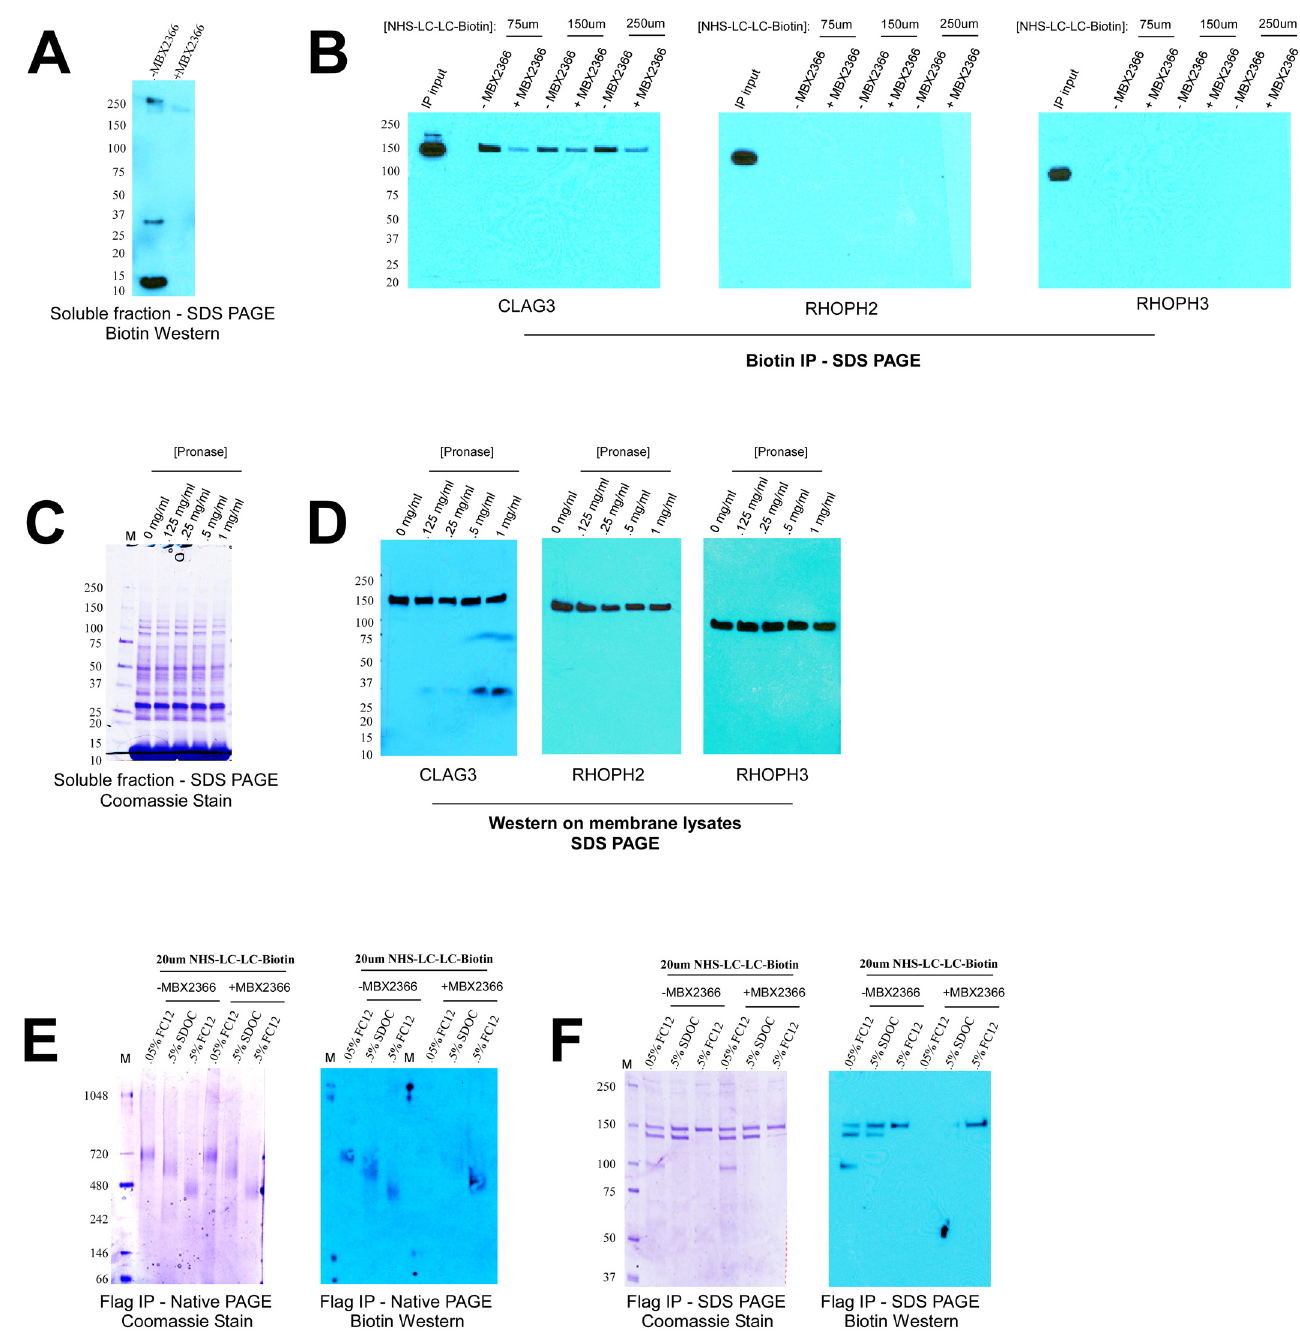
Fig 4. The 480kDa complex composed of CLAG3 localizes to the erythrocyte membrane. (A) Incubation of infected erythrocytes with extracellular NHS-LC-LC-Biotin results in labeling of intracellular proteins due to traversal through PSAC, which is prevented in the presence of PSAC inhibitor, MBX2366. (B) Membranes of biotin-labeled cells were solubilized with 1% FC12 and subjected to biotin IP, followed by Western blot for the indicated proteins. As indicated by the IP inputs, 1% FC12 is able to equally solubilize CLAG3, RHOPH2 and RHOPH3. However, only CLAG3 is found in the biotin IP eluate indicating localization to the erythrocyte surface. (C) Treatment with extracellular pronase-E does not result in the cleavage of intracellular proteins. (D) Extracellular pronase-E results in the appearance of a cleavage fragment for CLAG3, but not RHOPH2 and RHOPH3, in a dose-dependent fashion. C-terminal antibodies were used for all three proteins. (E) Extracellular biotin labeling results in labeling of the 480kDa complex in the presence of MBX2366 indicating that this complex localizes to the erythrocyte membrane. (F) Consistent with the above results, Western blot analysis with biotin antibody shows that only the CLAG3 obtained with 0.5% FC12 (corresponding to the 480kDa complex) labels with biotin in the presence of MBX2366.